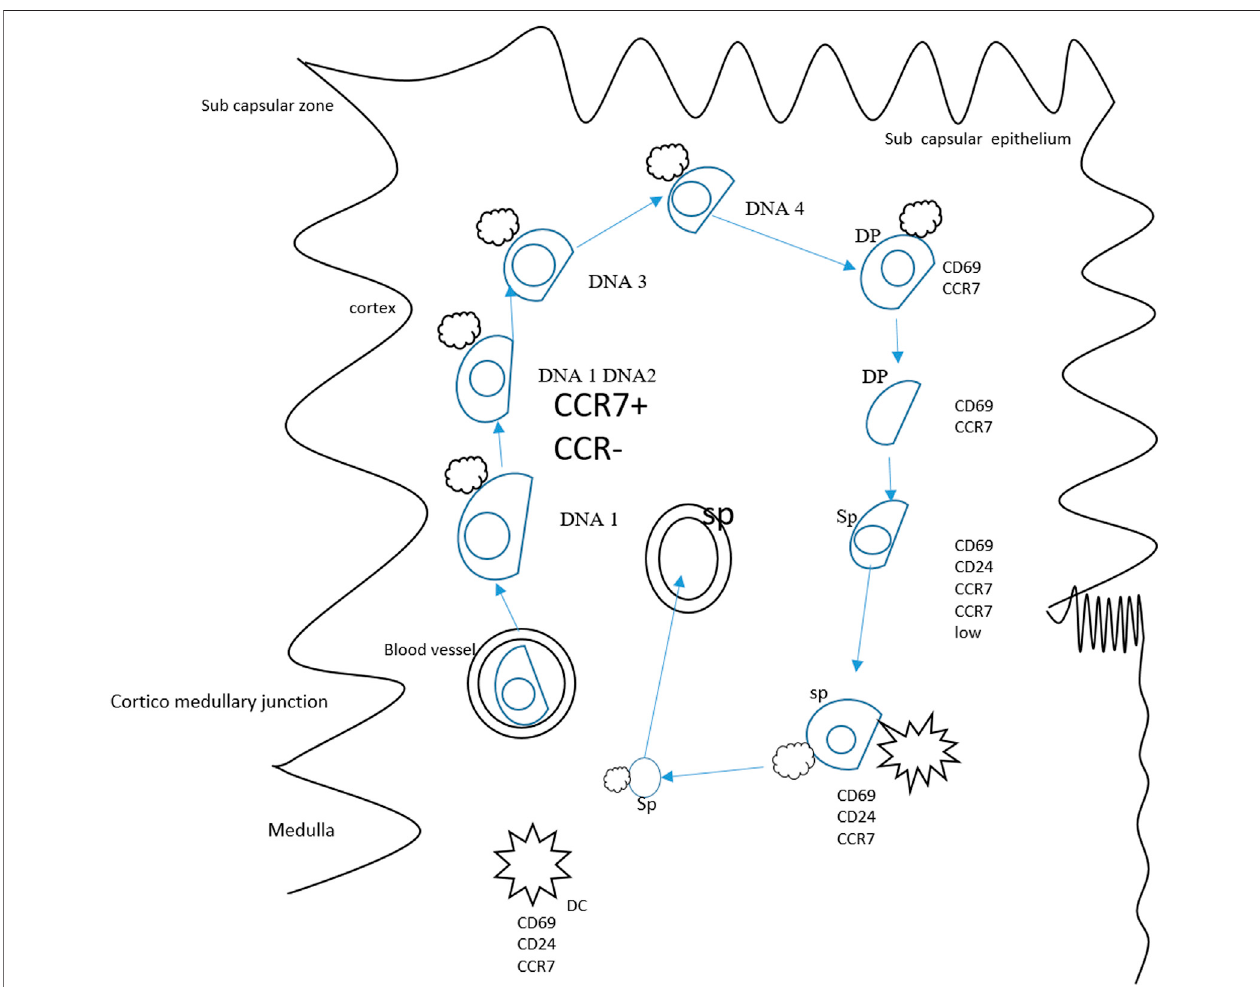
FIGURE 4 | Role of CCR7 in the migration of thymocytes. Thymocyte progenitors derived from bone marrow travel to the thymus. As the CD4/8 lacks expression, thecellsareknownasdouble-negativecells.TheDN1cellsdifferentiateatthethymicentrysite,andtransformationtoDN2occursinthemidcortex.TheDN3thymocyte differentiation happens while cells migrate to the outer cortex and developed into DN4 cells in the sub-capsular zone. The double-negative dendritic cell transition to the double-positive phase is accomplished in reverse migration and the double-positive thymocytes enter the medulla. In the medulla, positively double-positive cells mature and result in the production of CD4 + /CD8 + . A small population of double-positive cells expresses CCR7 and might drive the migration of double-positive cells to the medulla from the cortex. The CCR7 also plays a key role in mature single positive CD62L cells and guides the maturation of these cells. In this period, thymocytes interact with dendritic cells and medullary and thymic epithelial cells, deleting auto-reactive thymocytes and guiding positive selection.